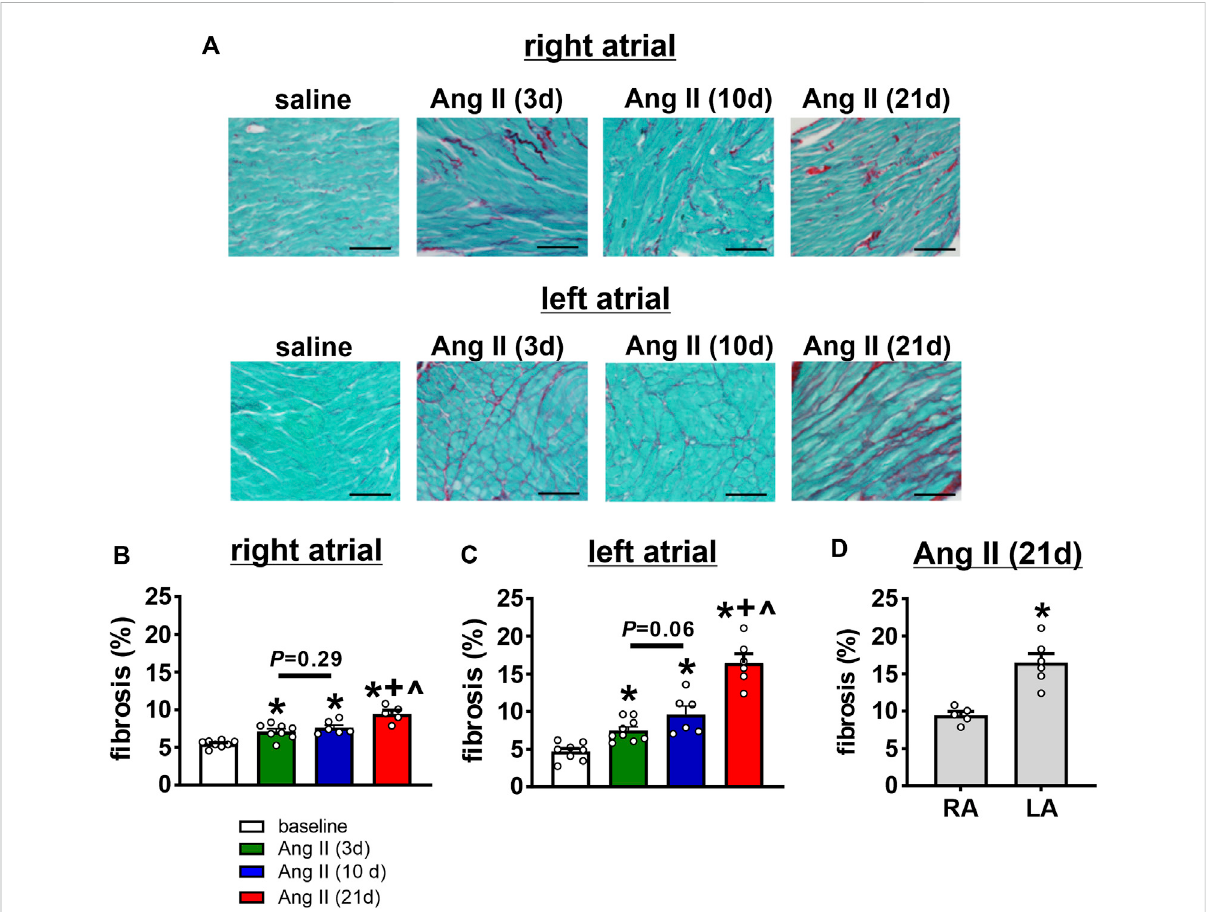
FIGURE 10 Time course of the effects of Ang II on right and left atrial fi brosis. (A) Representative images demonstrating interstitial fi brosis (collagen fi bres stained red) in the right and left atria in mice infused with saline for 21 days or Ang II for 3, 10 and 21 days of Ang II. (B – C) Summary of interstitial fi brosis in the right (B) and left (C) atria of mice infused with saline or Ang II for 3, 10 and 21 days. * p < 0.05 vs saline, + p < 0.05 vs Ang II (3 days), ^ p < 0.05 vs Ang II (10 days) by one-way ANOVA with a Holm-Sidak posthoc test. For right atrium n =8 saline, 8 Ang II (3 days), 6 Ang II (10 days) and 5 Ang II (21 days). For left atrium n =8 for saline, 9 for Ang II (3 days), 6 for Ang II (10 days), 6 for Ang II (21 days). (D) Comparison of fi brosis in the right (RA) and left (LA) atria of mice after 21 days of Ang II infusion. * p < 0.05 vs RA by Student ’ s t -test; n =5 for RA and 6 for